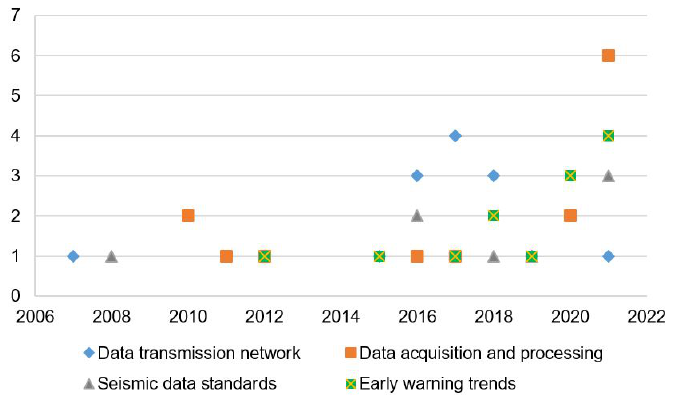
Figure 5. Year of publication per applications